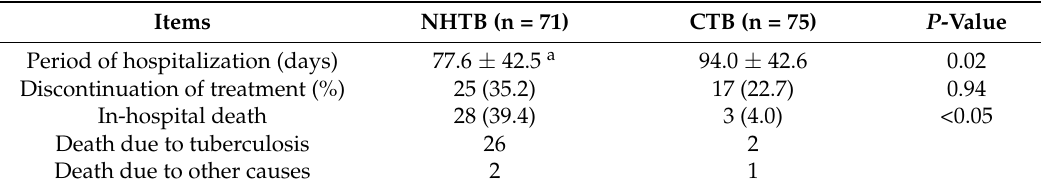
Table 4. Clinical courses of patients with NHTB and